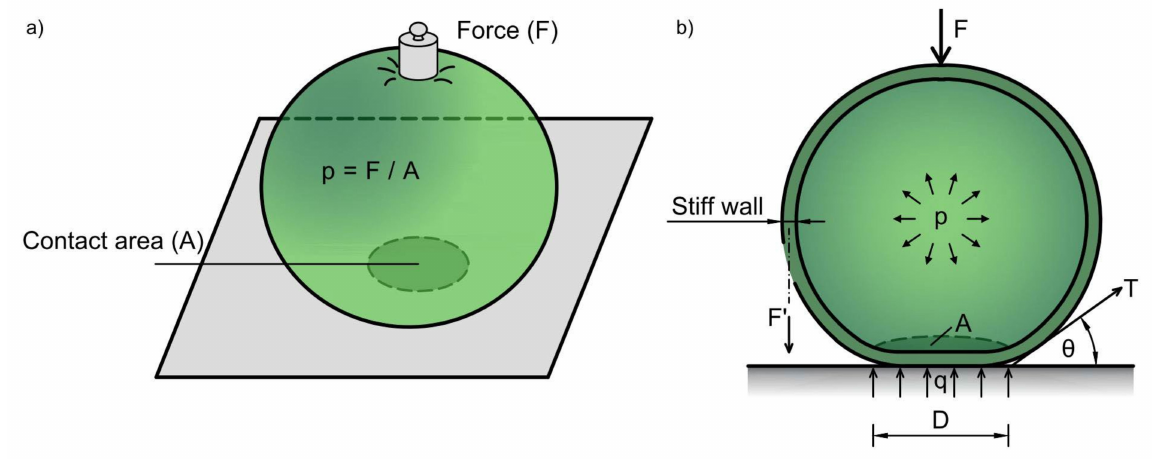
Figure 1. The power play of an absolutely flexible balloon ( a ) and a balloon with wall stiffness ( b ) contacting a smooth horizontal